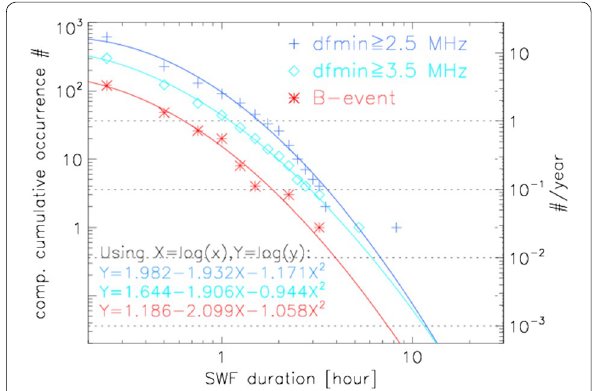
Fig. 7 Complementary cumulative distribution function of SWF duration from ionosonde observation (pluses, diamonds, or asterisk marks) and fitting functions (solid lines) for SWFs with the criteria of d f